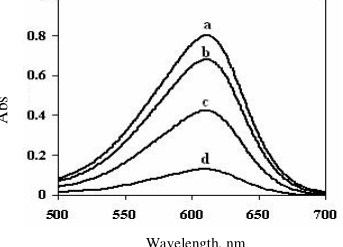
Figure 2. Effect of time on 1.0 µ g mL -1 and 8 µ g mL -1 of STS for method A and method B respectively